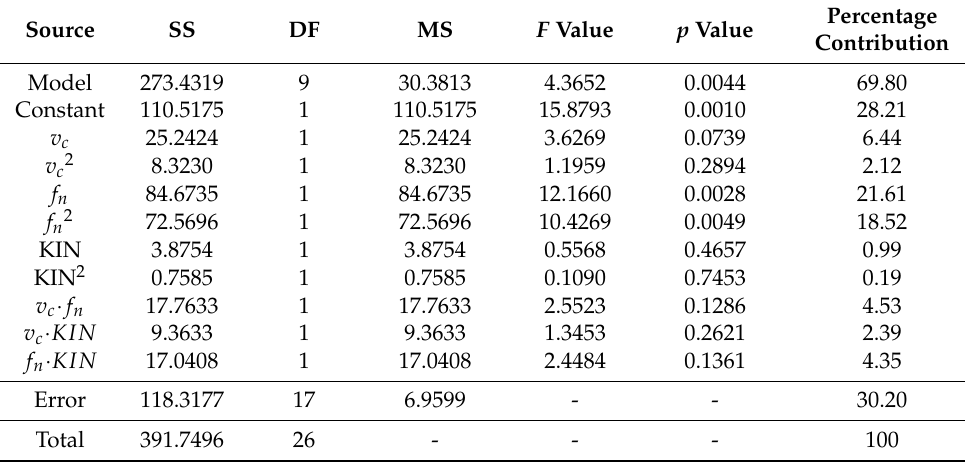
Table 6. ANOVA results for the cylindricity